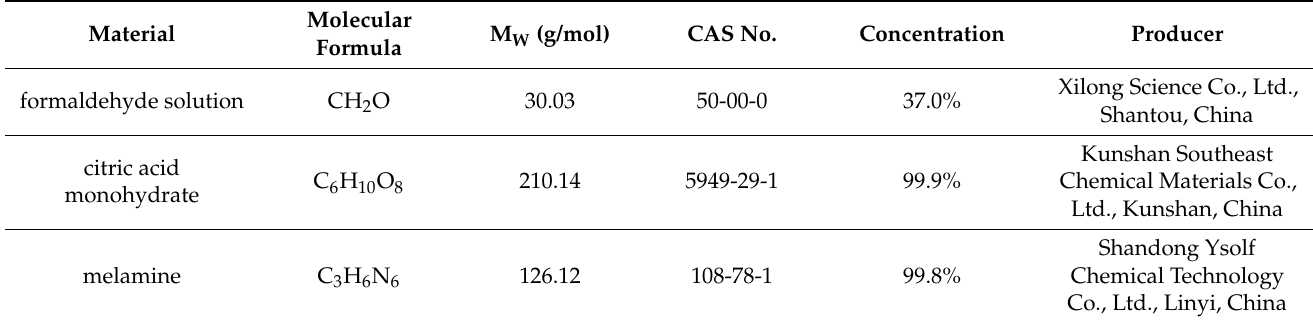
Table 1. List of experimental